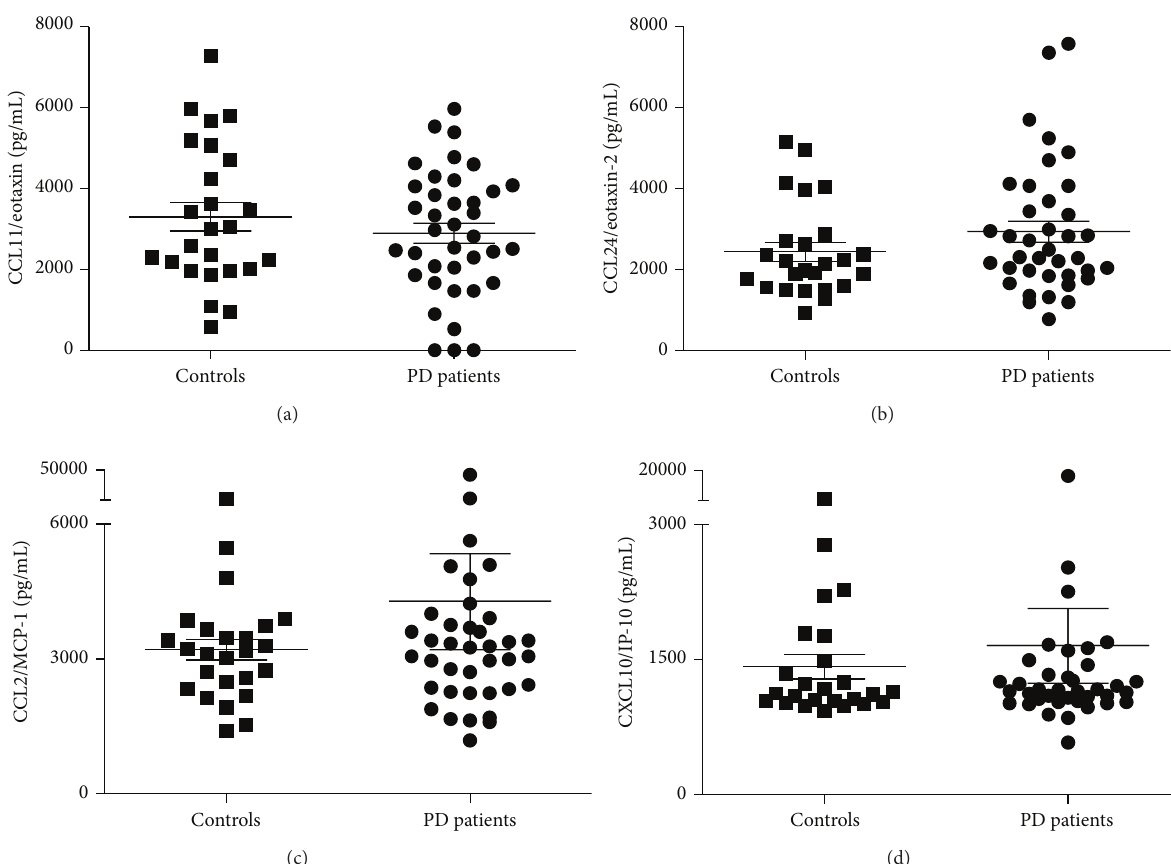
Figure 1: Control individuals and Parkinson’s disease (PD) patients did not differ regarding plasma levels of the evaluated chemokines CCL11/eotaxin (a), CCL24/eotaxin-2 (b), CCL2/MCP-1 (c), and CXCL10/IP-10 (d). The figure shows mean and standard deviation of the mean (SEM). IP-10: interferon gamma-induced protein-10; MCP-1: monocyte chemotactic protein 1; PD: Parkinson’s disease.